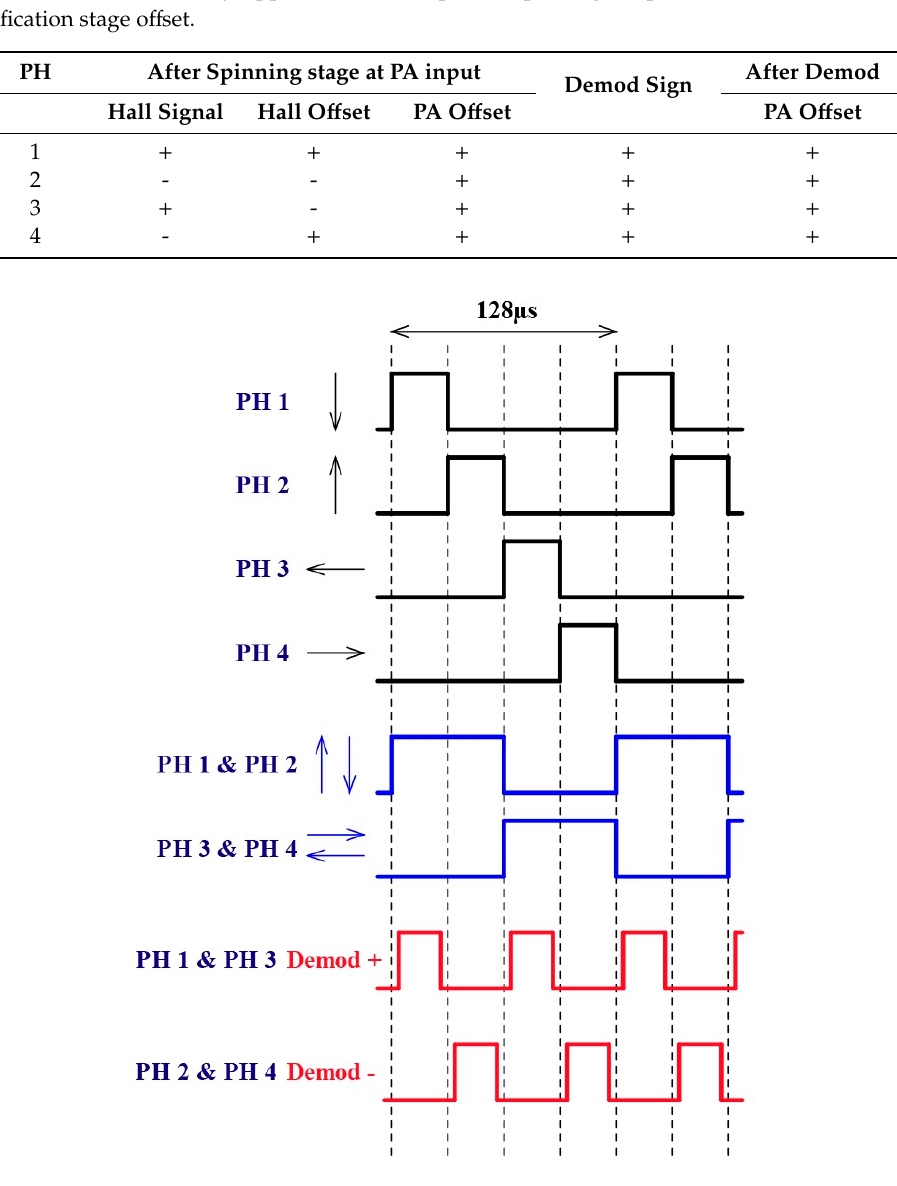
Figure 6. The set of eight signals required for proper spinning application. The top four PWM (pulse width modulation) signals control the current direction through the Hall probe with a period of 128 µs. The blue signals control the voltage readout polarity and the bottom red signals determine the demodulation key applied.